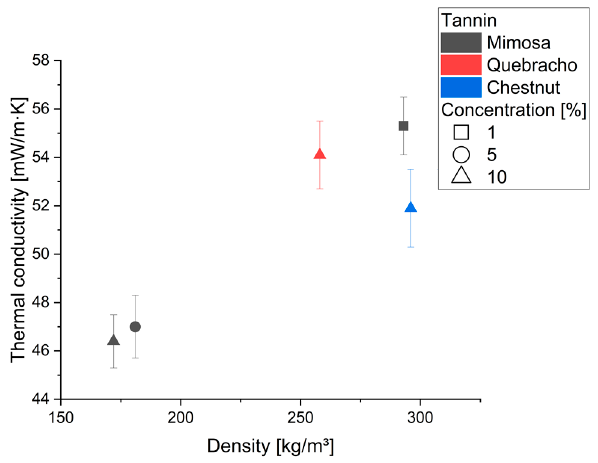
Figure 2. Thermal conductivity for the foams produced with mimosa at 1, 5, 10% surfactant concen- tration and quebracho/chestnut at 10%.